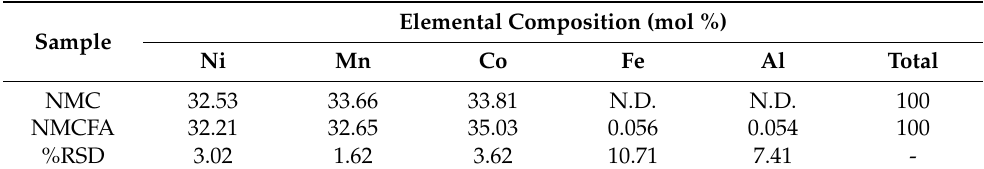
Figure 1. SEM images of the synthesized cathode active materials: ( a – c ) NMC and ( d – f ) NMCFA. Table 1. Elemental composition and relative standard deviation of the cathode active materials resulting from ICP-MS analysis.